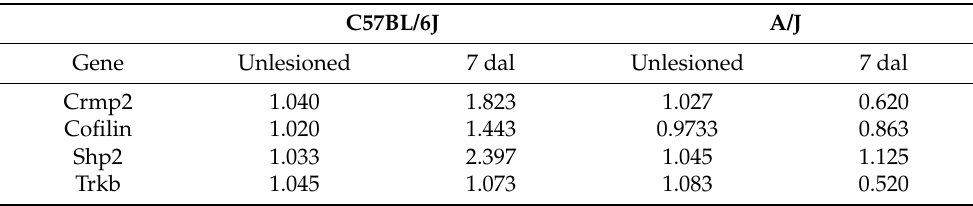
Figure 8. Relative expression of axonal cytoskeleton-related genes in microdissected motoneurons present in the dorsal lamina IX of Rexed ( A ) in control animals and 7 days after sciatic nerve crush. ( B ) trkb mRNA levels, ( C ) cofilin mRNA levels, ( D ) shp2 mRNA levels, and ( E ) crmp2 mRNA levels. Mean ± SEM (* p < 0.05; ** p < 0.01). Table 3. Relative gene expression (RT ‒ qPCR) in microdissected motoneurons present in the dorsal lamina IX of Rexed. Unlesioned = control. 7 dal = 7 days survival time after unilateral sciatic nerve crush at mid-thigh level.